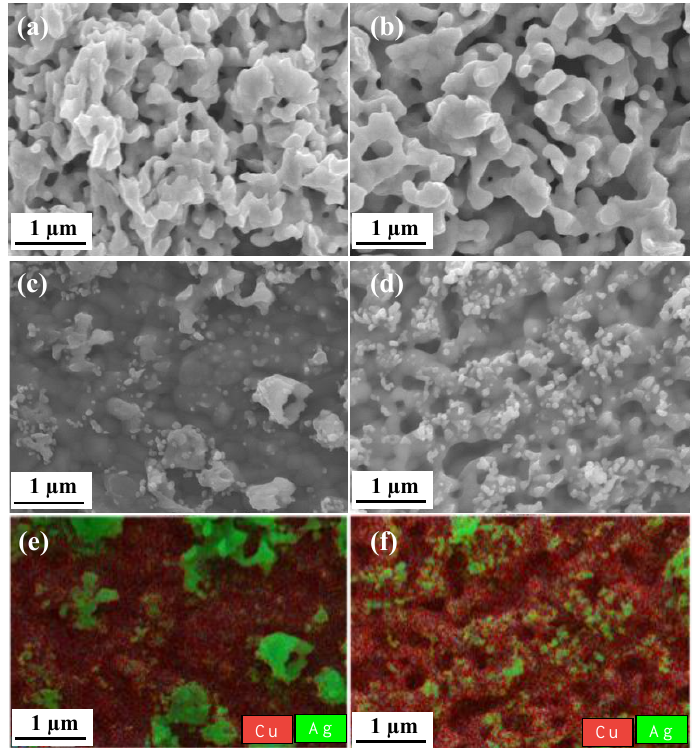
Figure 6. Fracture surfaces of the Cu substrate side from the samples bonded at 160 °C for 30 min. ( a , c ): sample bonded with the formic acid vapor; ( b , d ): sample bonded without the formic acid vapor; ( a , b ): fractures occurred in the sintered Ag layer; ( c , d ): fractures occurred at the interface between the sintered Ag layer and the Cu substrate; ( e , f ) are the energy-dispersive X-ray spectroscopy (EDS) mapping corresponding to ( c , d ), respectively. Red and green represent Cu and Ag,